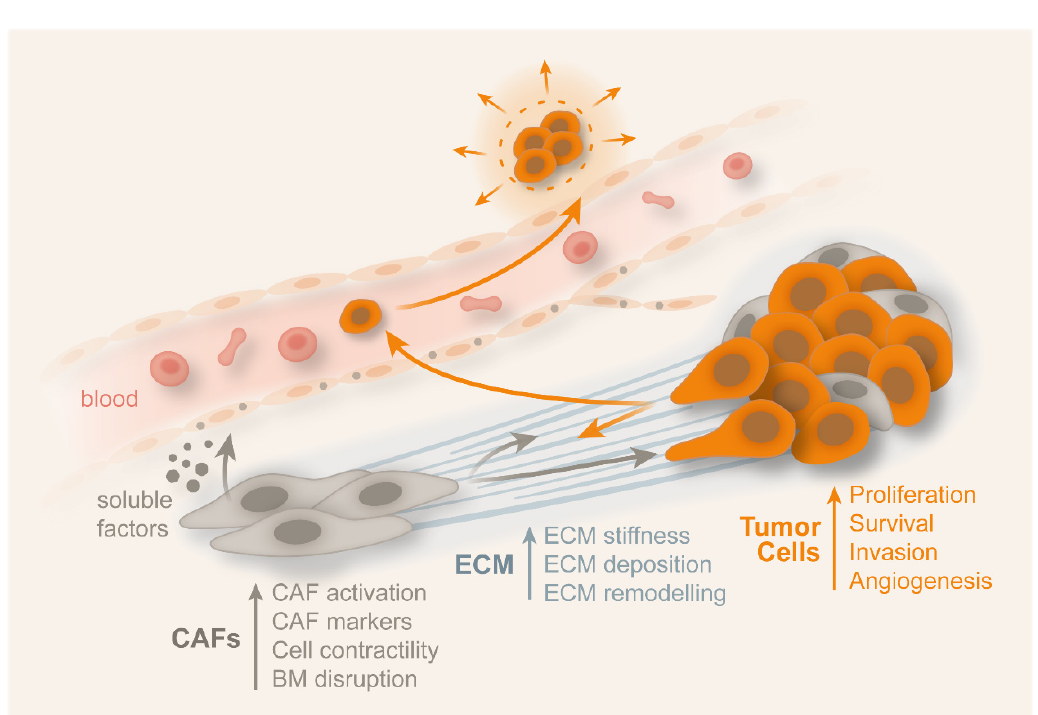
Figure 6. The stiffening and angiogenesis resulting from the remodeling of the ECM, is associated with the presence of cancer-associated fibroblasts (CAFs). Cancer cells at the leading edge of the tumor will assume epithelial-to-mesenchymal transition (EMT) and travel along collagen and fibronectin fibrils towards the vasculature. Due to CAFs, fibrils and collagenase are aligned at the edge of the tumor to promote invasion. The cell cytoskeleton will reorganize due to the shear forces sensed, eventually promoting adherence to the blood vessel wall. CAFs also contribute the disruption of the basement membrane. Adherent cells that survive will extravasate to a distant tissue. Cancer cells will not undertake mesenchymal-to-epithelial transition (MET), if the tissue is considerably stiff, and therefore the cells become dormant. MET will occur only if the elastic modulus is low and a secondary tumor will then be formed. With tumor progression, the matrix stiffness will increase. Adapted from Libring et al. [37] and Jang et al. [175].